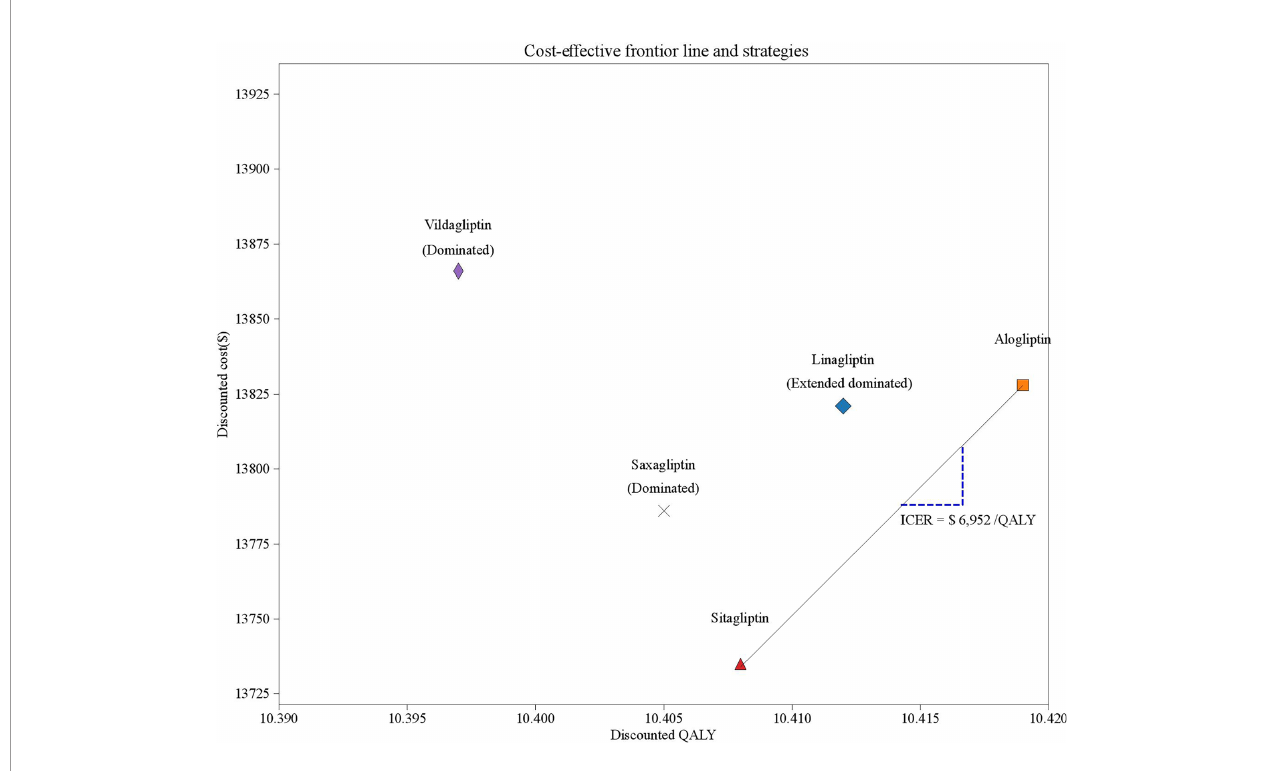
FIGURE 2 | The cost-effectiveness ef fi ciency frontier of fi ve competing strategies.